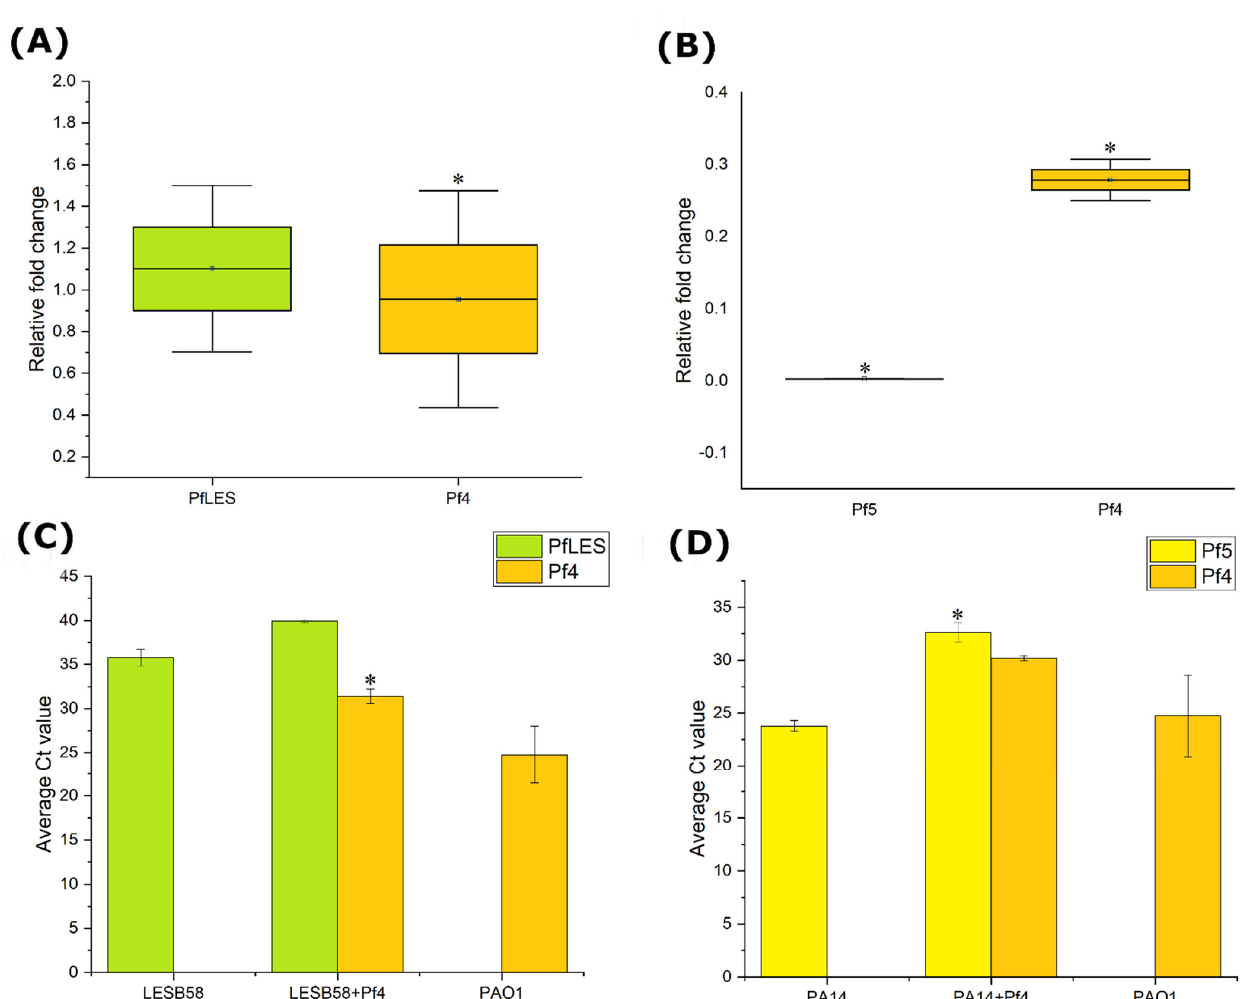
Figure 3. qRT ‐ PCR analysis of Pf4 and indigenous phage: ( A , B ) coaA expression at RNA level in LESB58 and PA14 strains after 6 h of incubation, respectively. Results are average + S.E; n = 6; calculated using 2 −ΔΔ CT method, and cut ‐ off for relative change in expression is >1.5 or <0.67. * >1.5 or <0.67 ( C , D ) qPCR analysis of Pf4 and indigenous phage production at viral DNA level in LESB58 and PA14 strains using RF of bacteriophages after 24 h of incubation, respectively. Results are average Ct values + S.E., n = 6, calculated using Student’s t ‐ test; * p < 0.05.